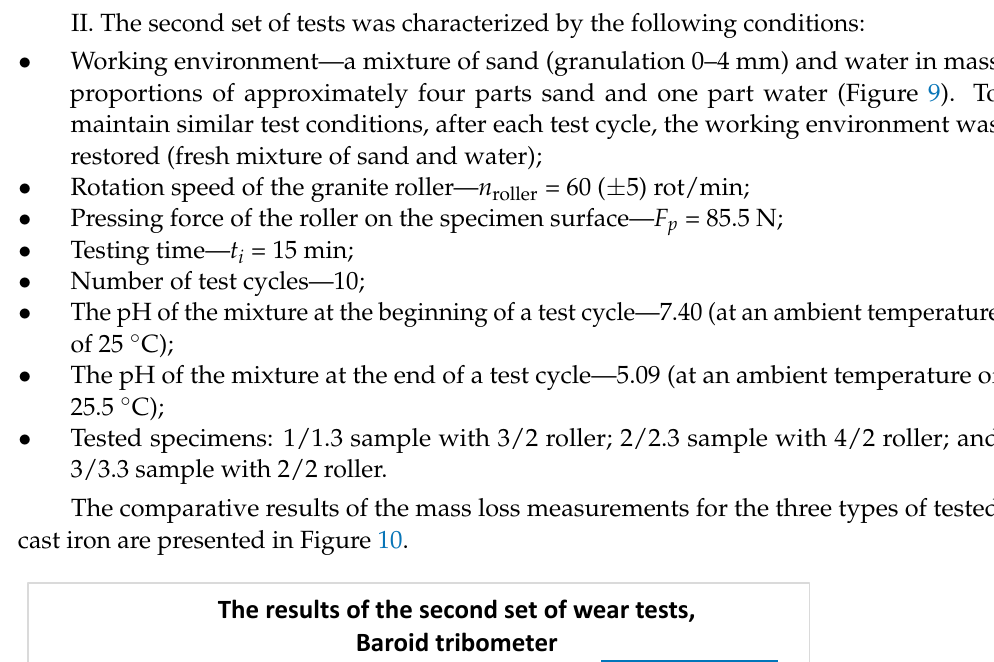
Figure 9. Worn mixer blade sample 2.2/1 (25% Cr) after 240 min—8 cycles of operation. For the first program test (cast iron–roll granite sample, without intermediate envi- ronment), the sample was taken from blade no. 3 (made of cast iron alloyed with 9% Cr), which had the lowest wear resistance.